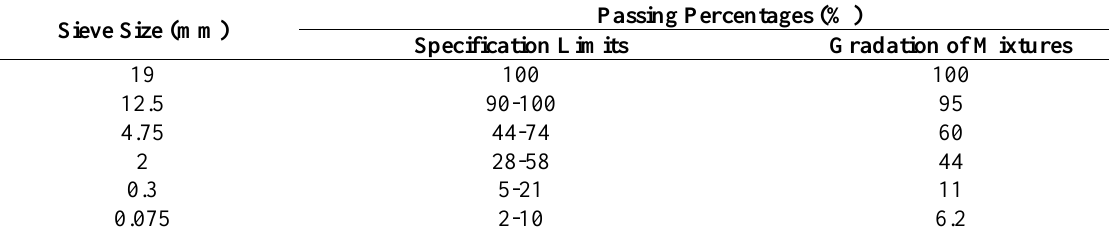
Table 2. Aggregates